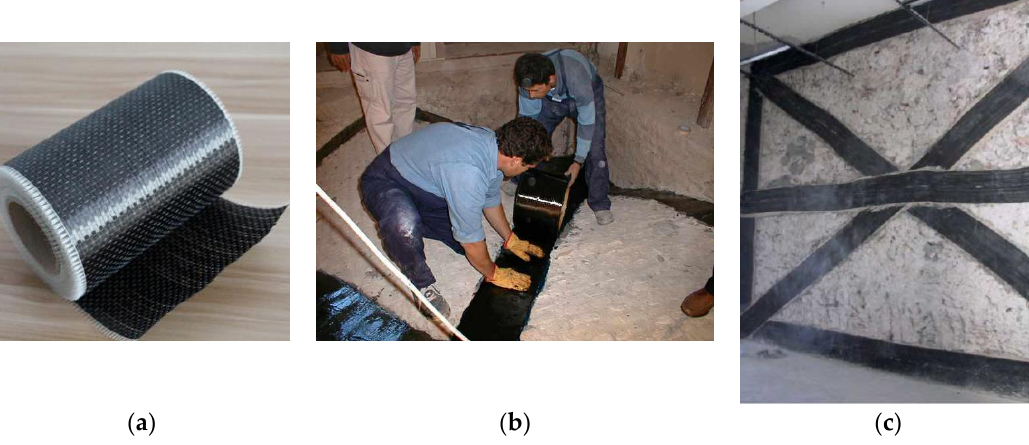
Figure 1. Application of a carbon-fiber-reinforced polymer (CFRP) sheet: ( a ) a CFRP bi-directional sheet, ( b ) use of epoxy-resins to bond the CFRP on the masonry surface, and ( c ) a reinforced wall panel.